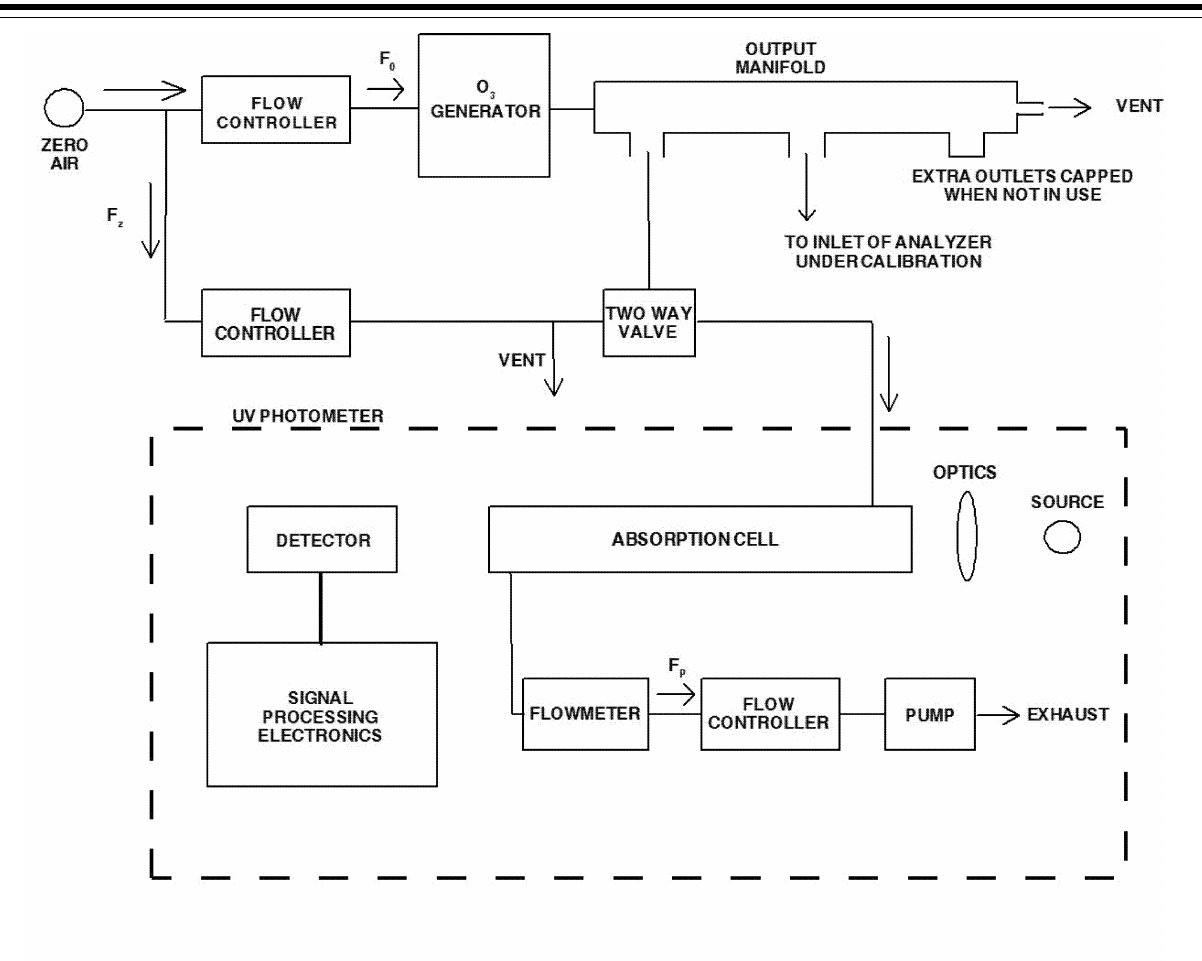
Figure 2. Schematic diagram of a typical UV photometric calibration